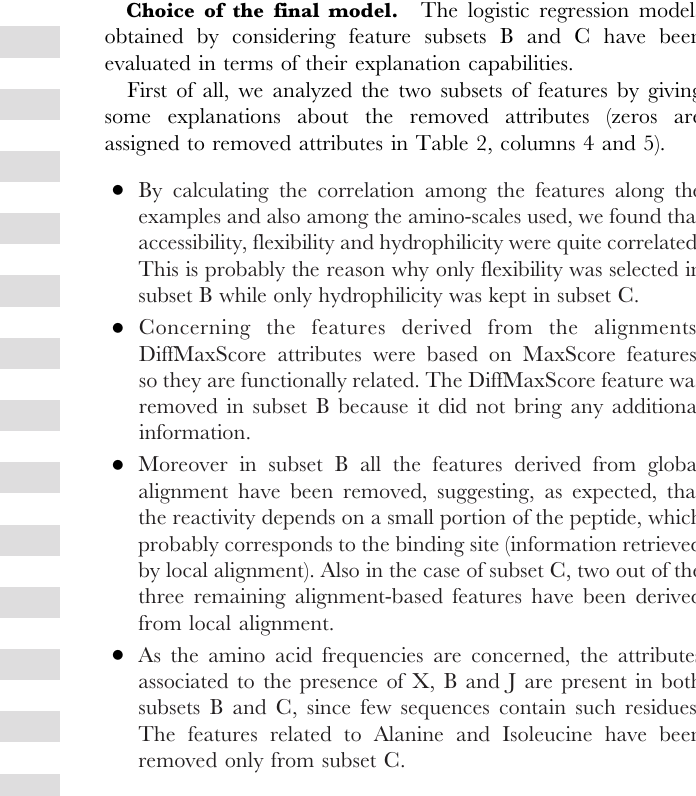
N Linear regression and logistic regression show the highest performance, even if the difference between the results of the different classifiers is not statistically significant. N We tested linear regression by both considering discrete or continuous outcomes. This first alternative always gave the best results.